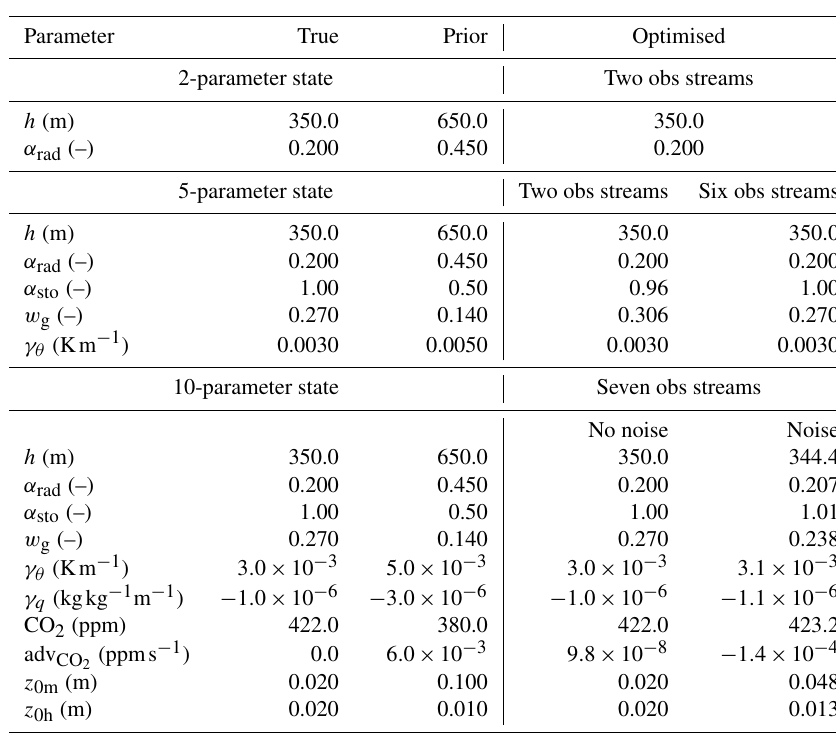
Table 2. Parameter values for the main observation system simulation experiments of Sect. 8.1. The observation streams used in the two obs (observation) streams experiments are q and h , for the six obs streams experiment, H , LE , T 2 , and F CO obs streams experiments, CO 220 is additionally added. The value of, for example, parameter z 0m (only a state element in the 10-parameter- state experiments) is in the 2-parameter-state and 5-parameter-state experiments equal to the true value of z 0m in the 10-parameter-state experiments. See Table A1 for a description of the parameters and Table A2 for a description of the observation streams. Note: ppm is parts per million.